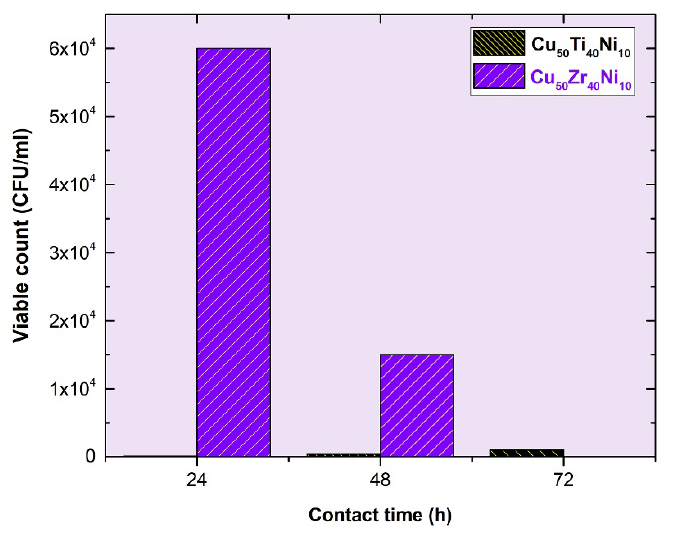
Figure 15. Inhibition of biofilm adhesion by E. coli (ATCC 25922) on ternary C 50 Ti 40 Ni 10 and Cu 50 Zr 40 Ni 10 systems.